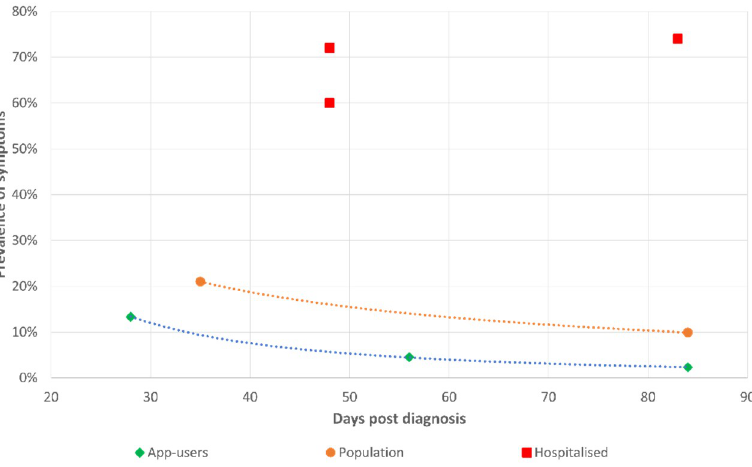
Fig 2. Symptom prevalence across studies identified in the UK by duration and severity